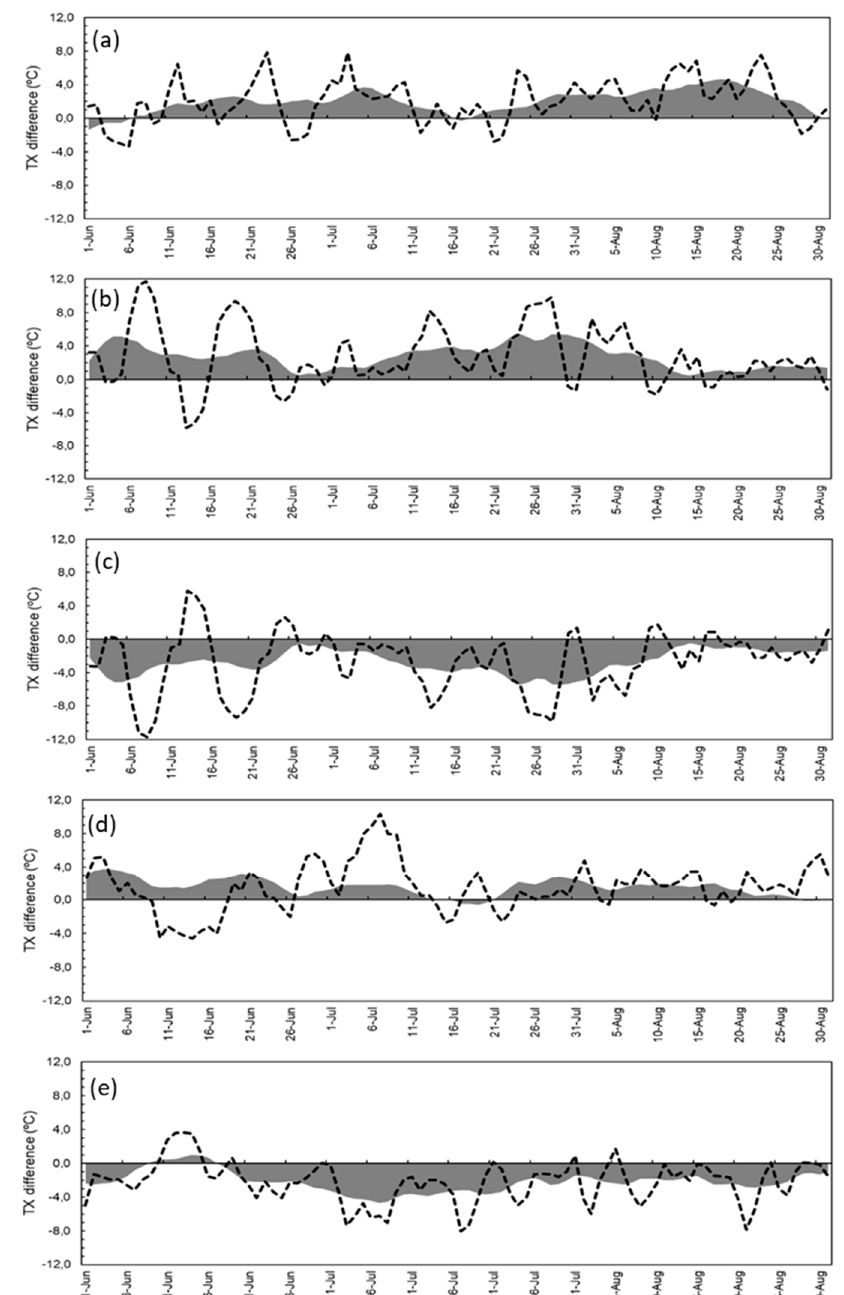
Figure 6. Cluster 2 – Cluster 1 differences in the mean TX (in °C) from 1 June to 31 August (dashed lines) for: ( a ) berry weight and total phenols index in Alentejo; ( b ) anthocyanins in Alentejo; ( c ) pH and potential alcohol in Alentejo; ( d ) titratable acidity in Dão; ( e ) potential alcohol in Douro-C. All parameters are for TON. The 11-day moving averages are also outlined (grey shaded areas).